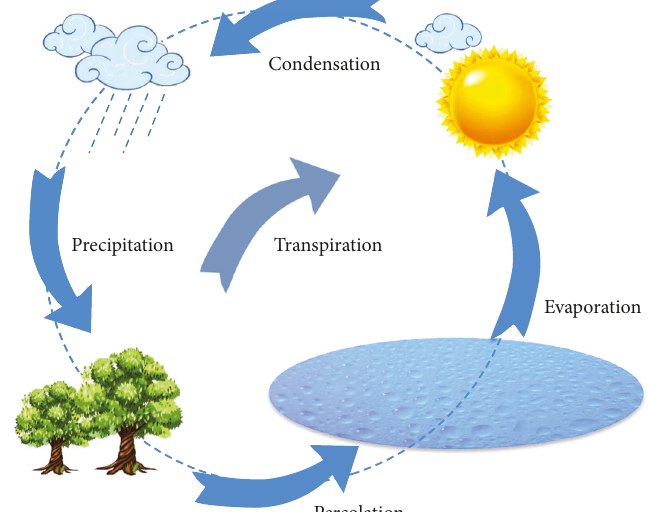
Figure 4: The process of water